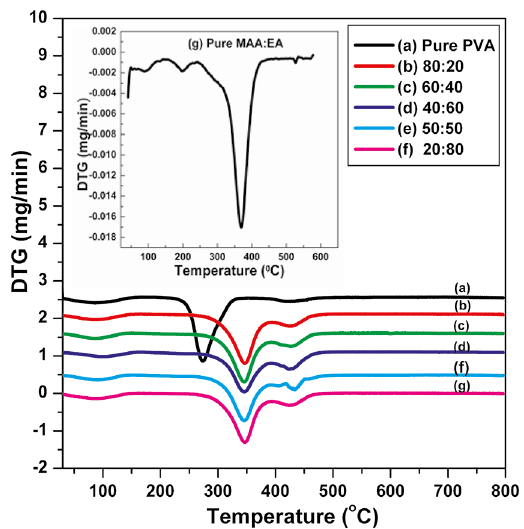
Figure 5. DSC curve of pure MAA:EA copolymer